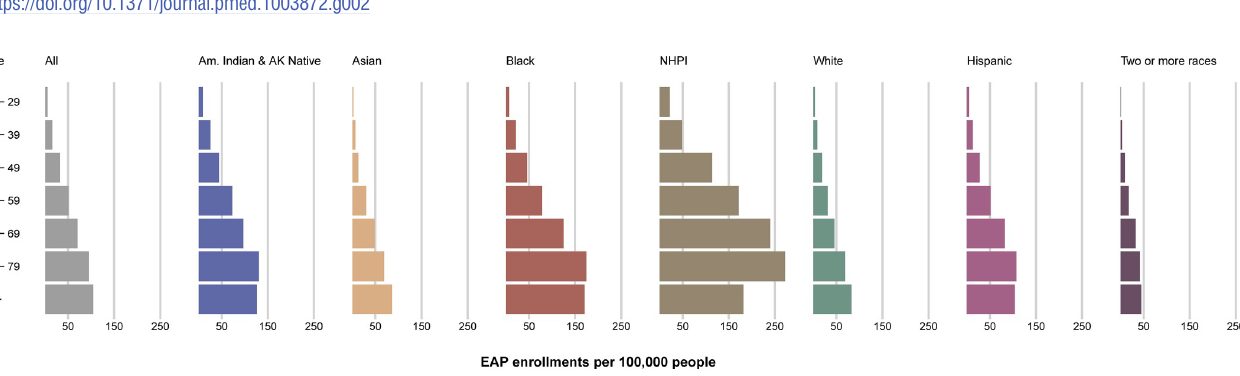
PLOS Medicine| https://doi.org/10.1371/journal.pmed.1003872 December20, 2021 18 /